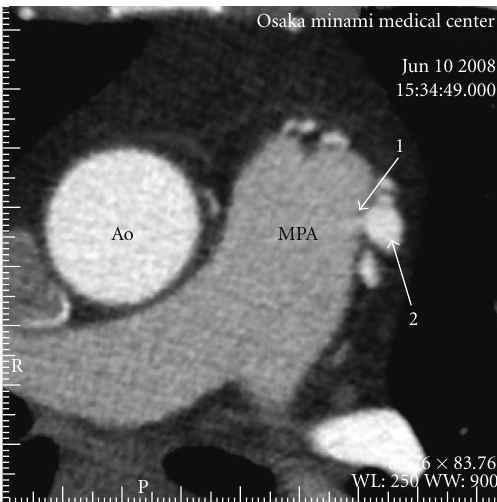
Figure 1: Axial images demonstrated the leakage of contrast medium (1) into the main pulmonary artery (MPA) from the aberrant artery originating from coronary arteries (2). Ao = ascending aorta.